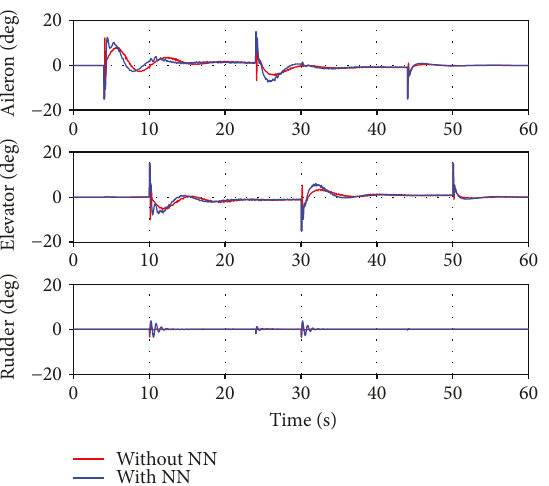
Figure 8: Euler angle response in scenario 1.